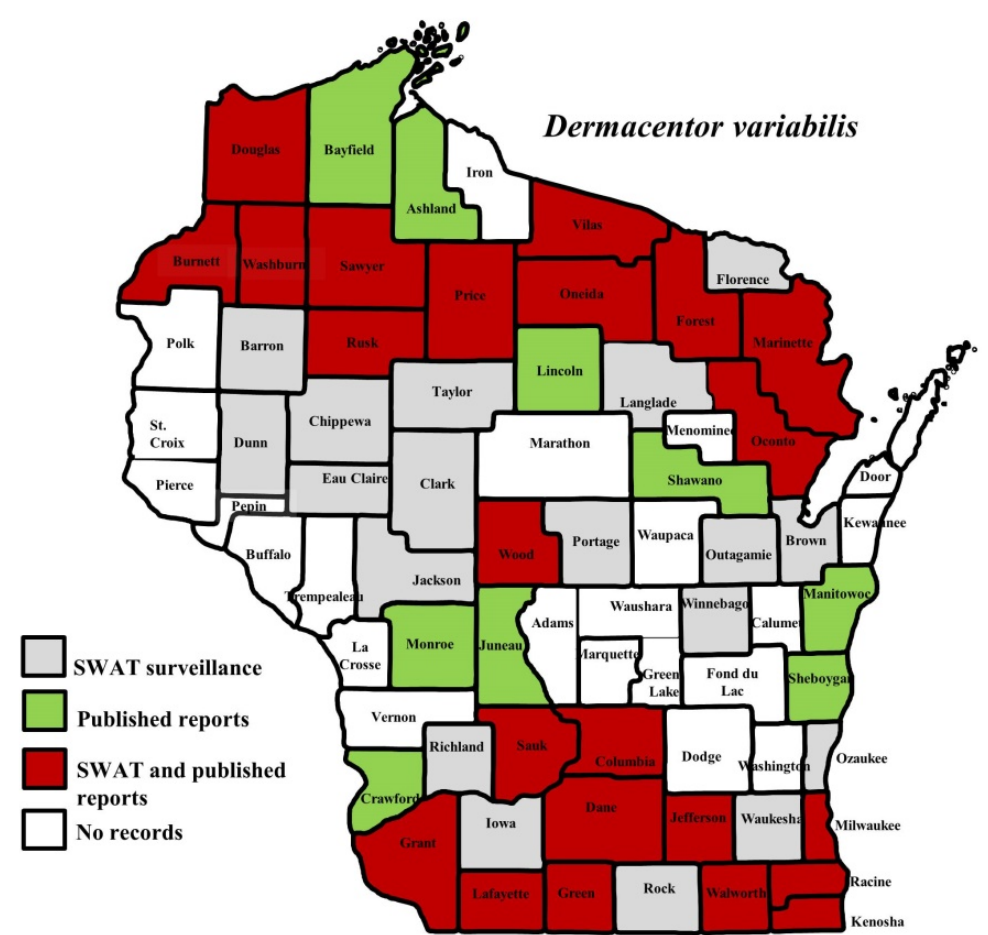
Figure 2. County records for the American dog tick, Dermacentor variabilis in Wisconsin [2,3,14,18,27,28].